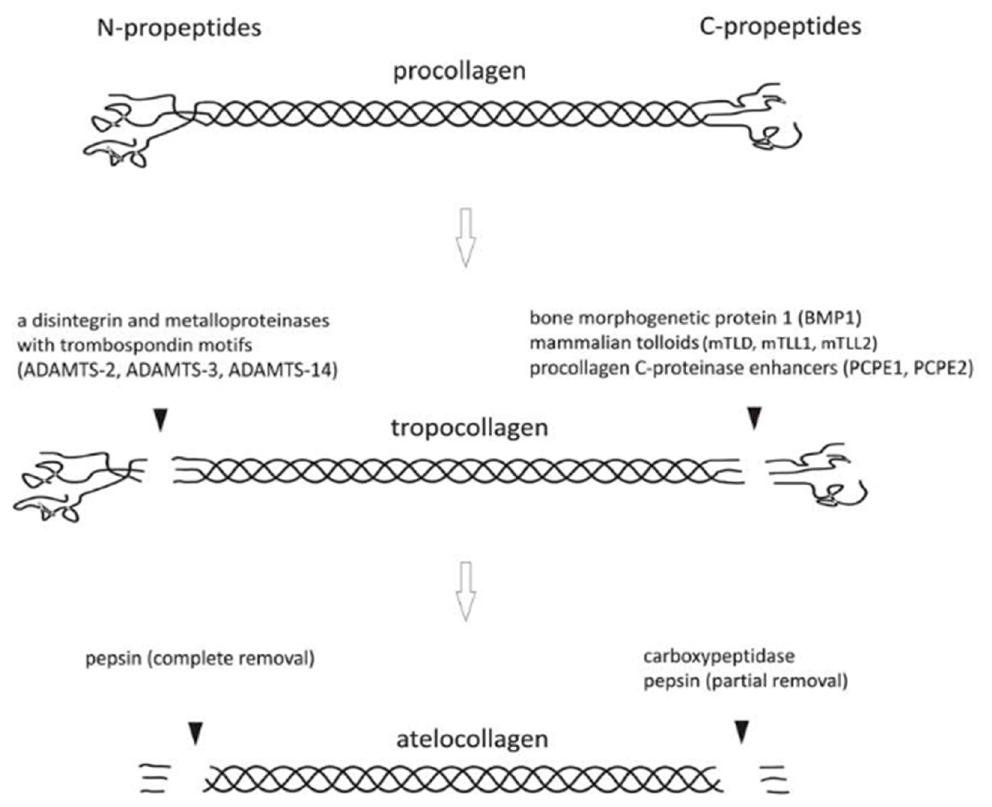
Figure 1. Type I collagen is biosynthesized as procollagen ; enzymatic cleavage of terminal propeptides forms tropocollagen ; further non-specific enzymatic cleavage of terminal telopeptides yields to atelocollagen . Reproduced with permission from [47]. Copyright The Royal Society of Chemistry